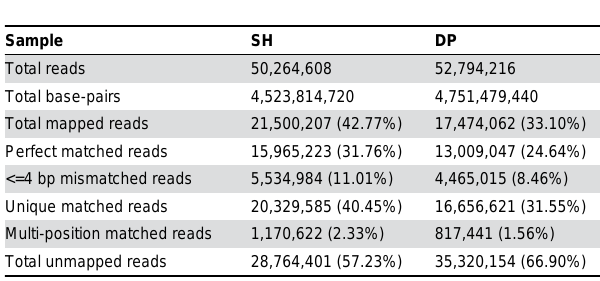
Table 2. A summary of the sequencing reads alignment to the reference